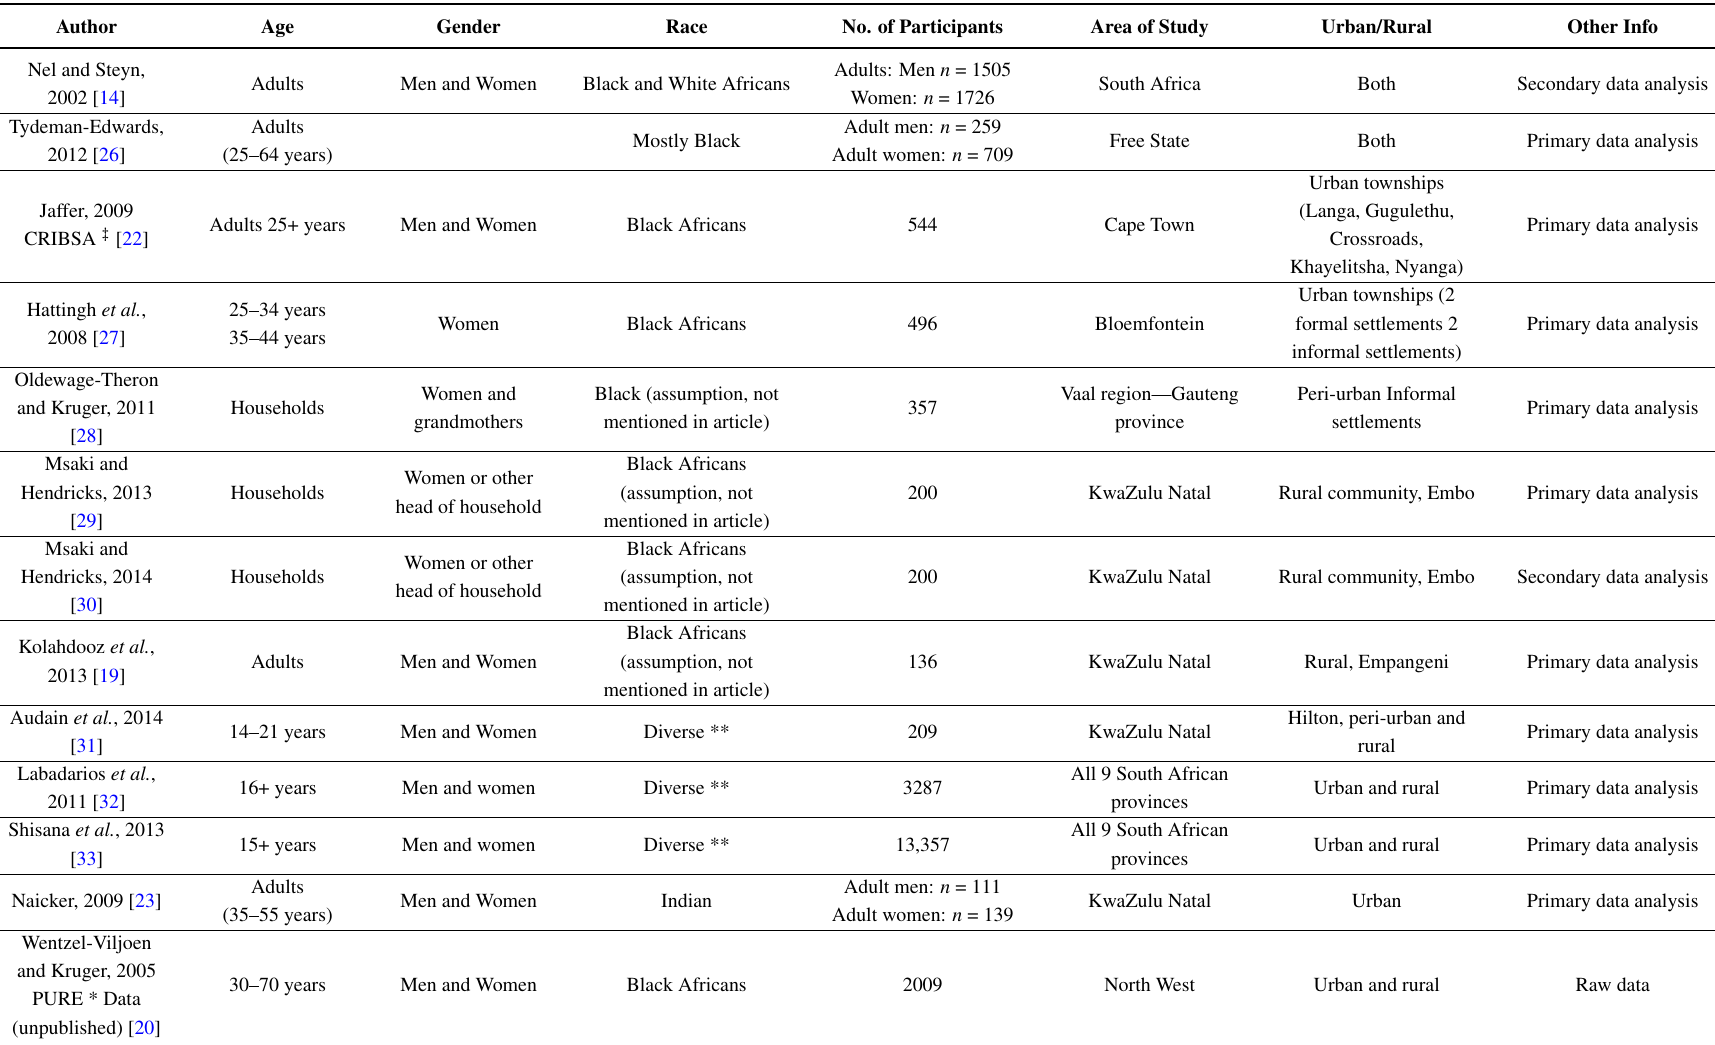
Table 1. Details of the reviewed